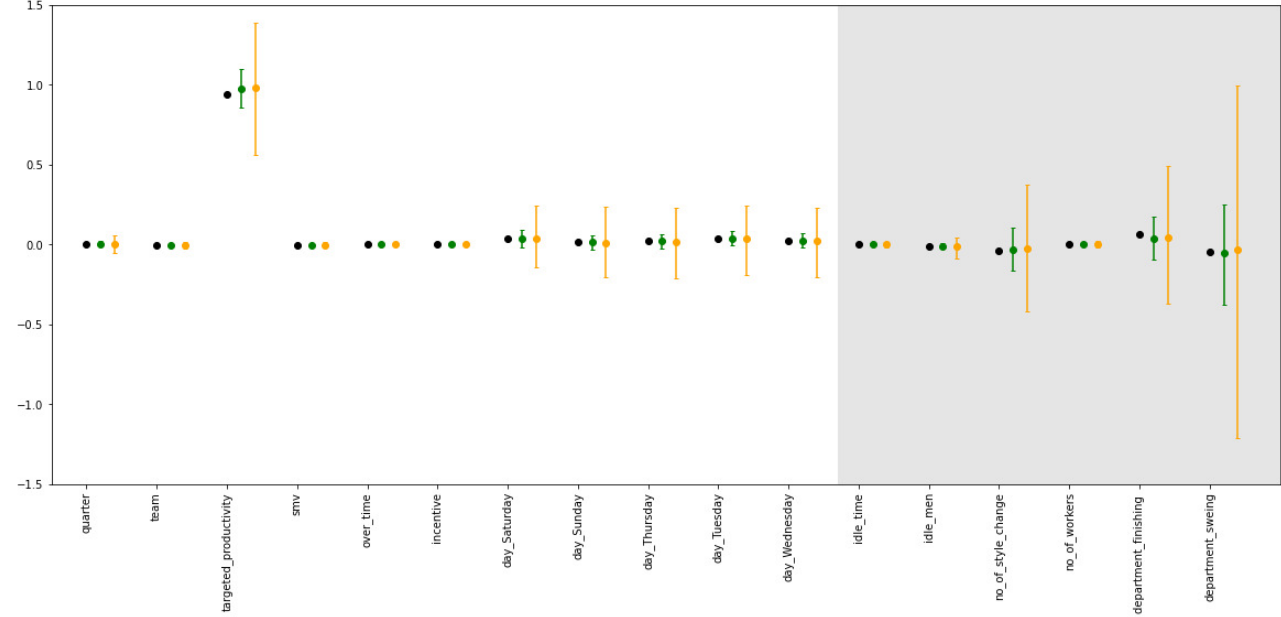
Figure 7. Centralized parameter estimates (black) for regression analysis with Garment employee productivity data set, with average coefficients and 95% confidence intervals for ε = 1 (orange) and ε = 10 (green), for γ = 1.2, 1000 repetitions. Parties are separated with background